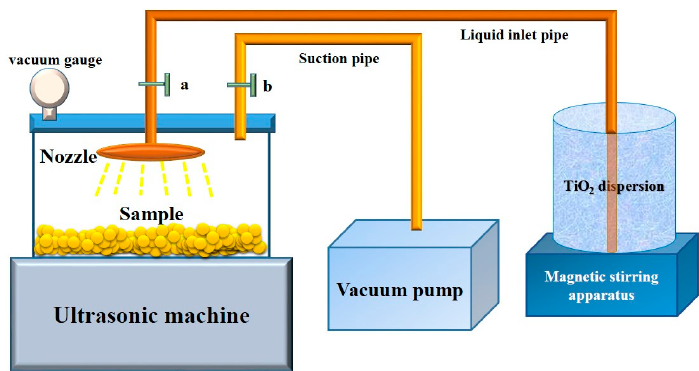
Figure 1. Diagram of the vacuum-ultrasonic-negative pressure devices.